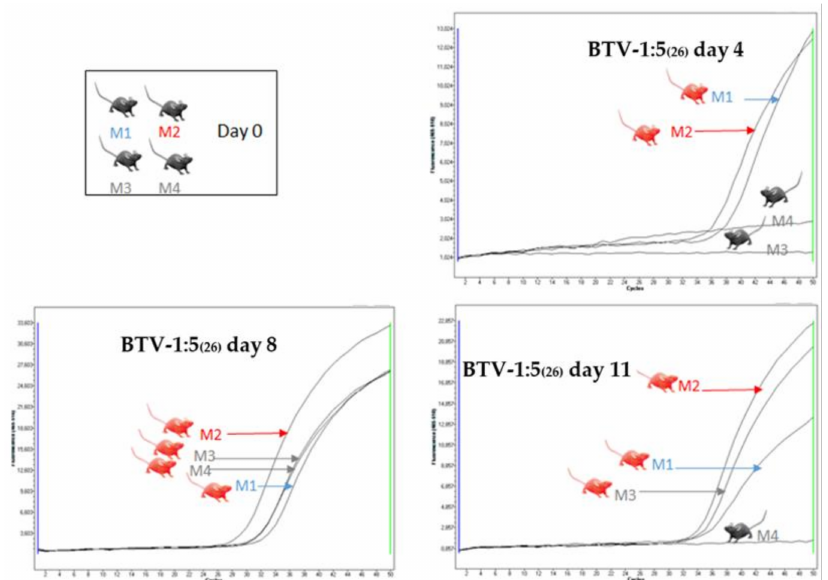
Figure 6. Real-time RT-PCR amplification curves for RNA extracts from blood samples of mice inoculated with BTV-1:5 (26) . On day 4 both inoculated mice (M1 and M2) are positive by real-time RT-PCR. On day 8 and 11, both in-contact mice (M3 and M4) were positive for BTV RNA. In one of the experiments, one in-contact mouse (M4) became negative on day 11 of the experiment.